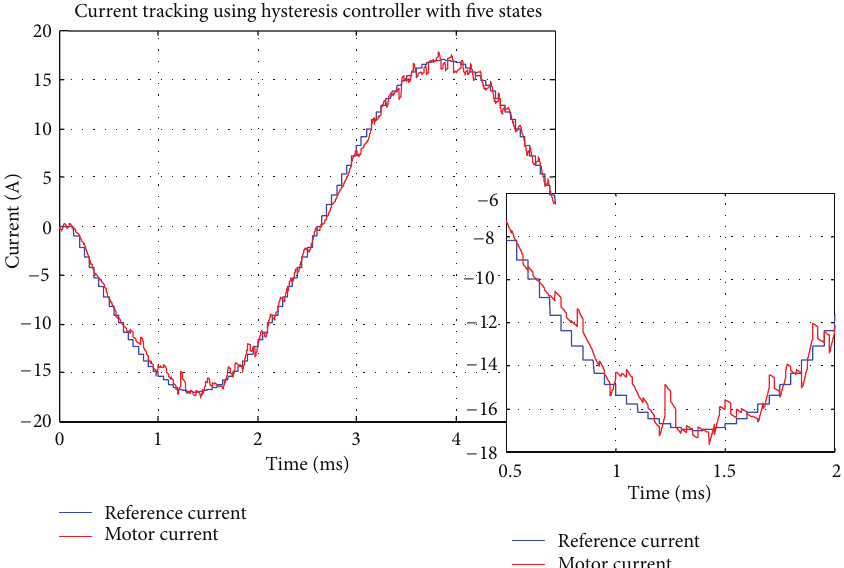
Figure 15: Current tracking obtained with the control scheme of Figure 14.